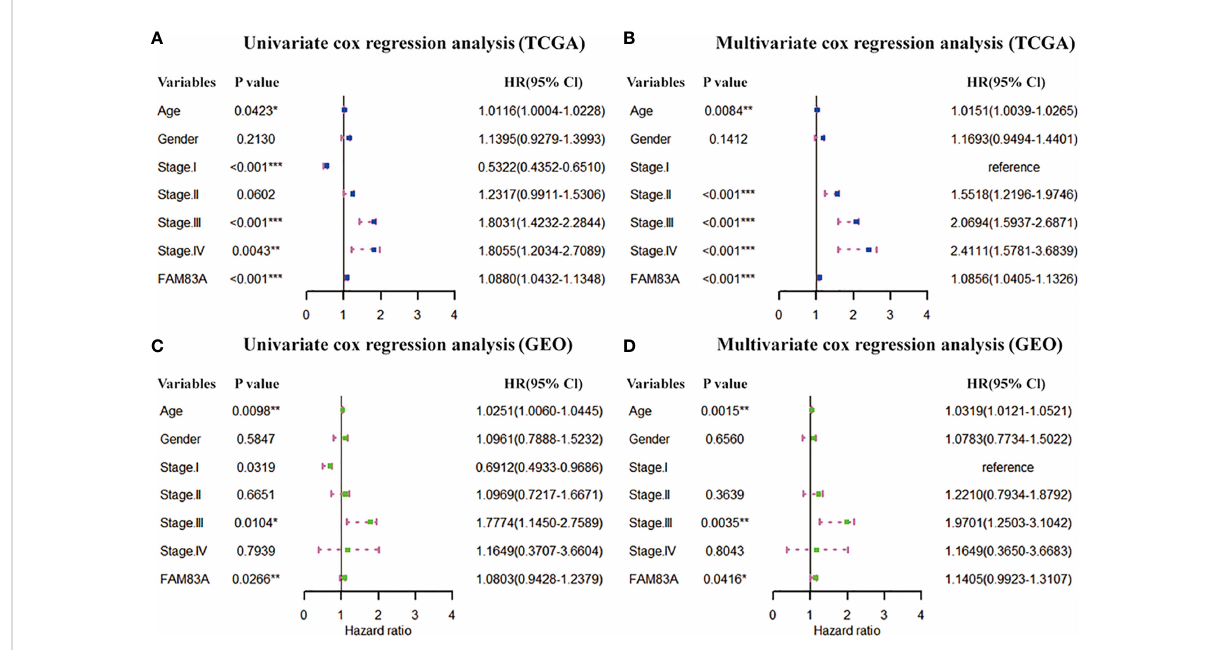
FIGURE 2 Prognostic independence of FAM83A based on TCGA and GEO datasets. (A) Univariate and (B) multivariate COX forest plot of FAM83A gene and clinical factors based on the TCGA data set. (C) Univariate and (D) multivariate COX forest plots of FAM83A and clinical factors based on GEO dataset. (*p<0.05, **p<0.01,